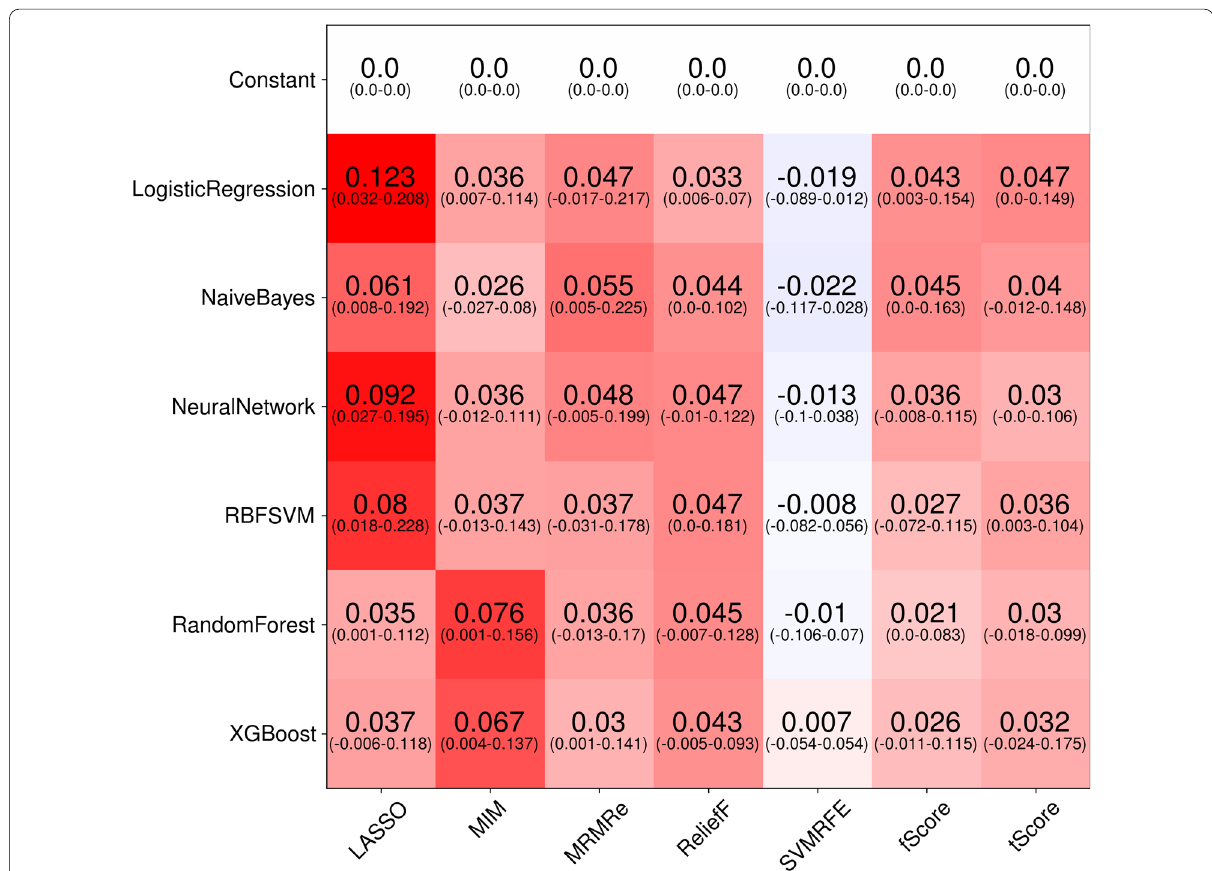
Fig. 4 Mean bias in AUC-ROC for each combination of feature selection and classification method over all datasets. To obtain these, for each of the 10 datasets, the largest difference in AUC-ROC for a given combination between correct and incorrect application of CV is computed, resulting in 10 differences. The mean of these differences is denoted, with the corresponding ranges below in parentheses. Since the displayed mean is an average of all datasets, a conclusion about the bias for a single dataset is not possible. For example, using SVM-RFE with a random forest shows almost no bias in mean ( 0.01), but the difference for a single dataset can be as high as 0.07 in −